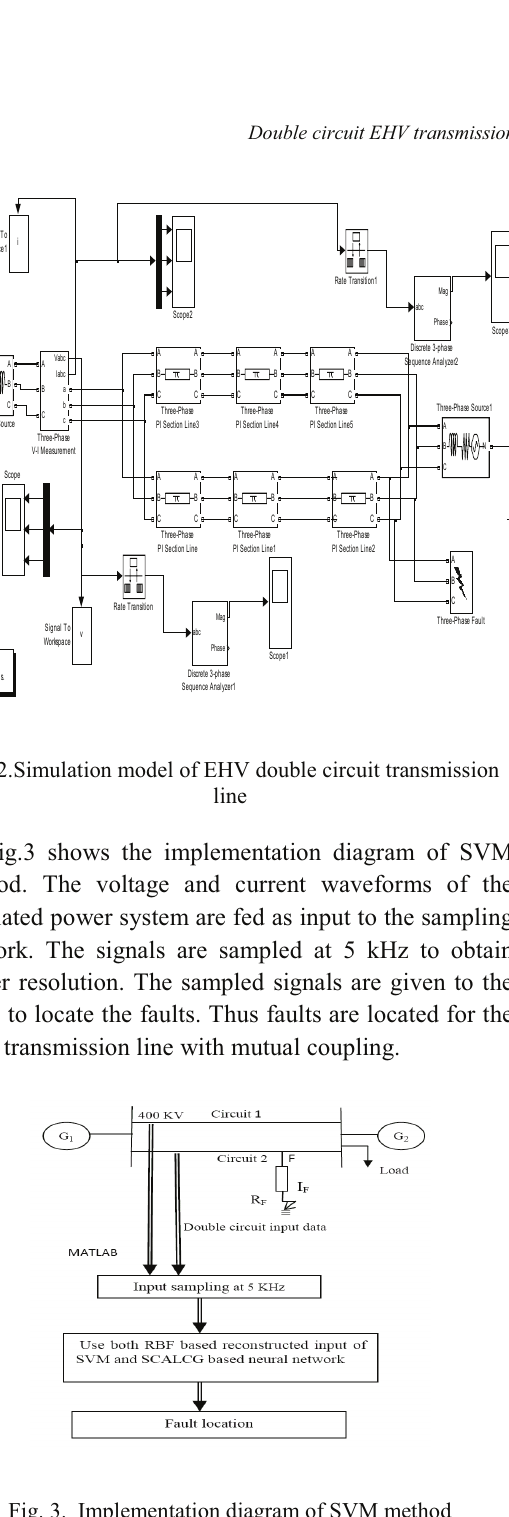
Fig. 3. Implementation diagram of SVM